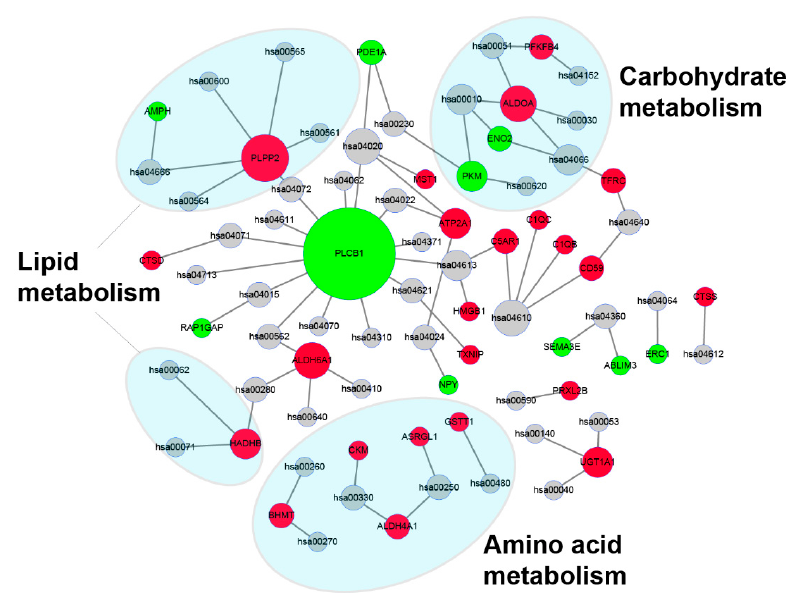
Figure 9. Network of enriched KEGG pathways and related genes. Red points represented the DEGs with an upregulated trend, green points are represented the DEGs with a downregulated trend, and gray points represent an enriched KEGG signaling pathway. Enriched metabolism-related pathways are shaded by a blue ellipse. Annotations of KEGG pathway are in Table S8.